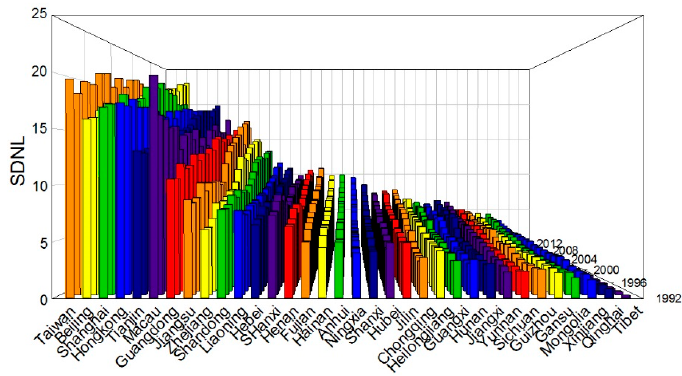
Figure 10. Mean nighttime light (MNL) at the provincial scale in China. Figure 11. Standard deviation nighttime light (SDNL) at the provincial scale in China.